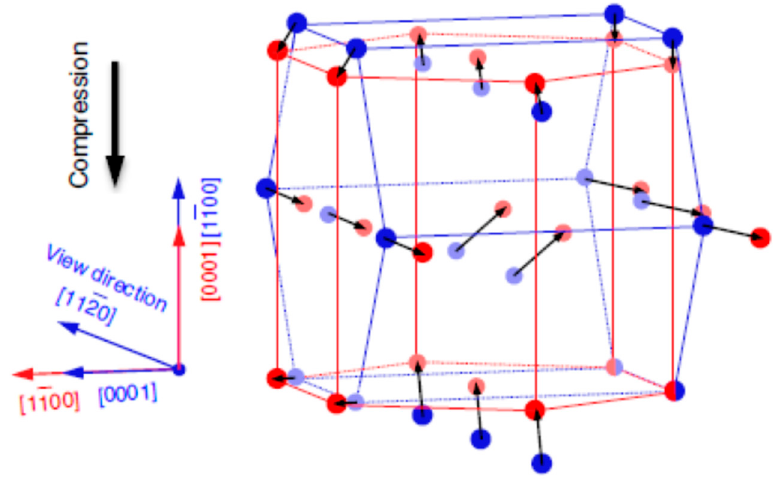
Figure 10. Transformation from parent hcp (blue) to twin hcp (red) via shuffling atomic rearrangement (Reproduced from [63], with permission of Springer Nature, 2014).